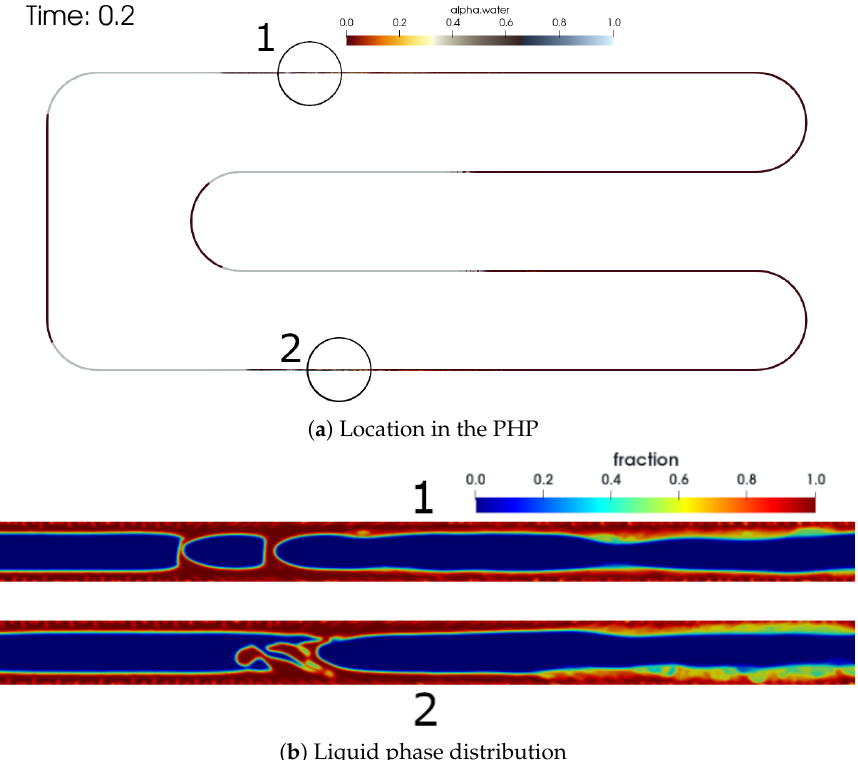
Figure 21. Numerical results of the Xu model [29] in 0.2 s for 75 W input